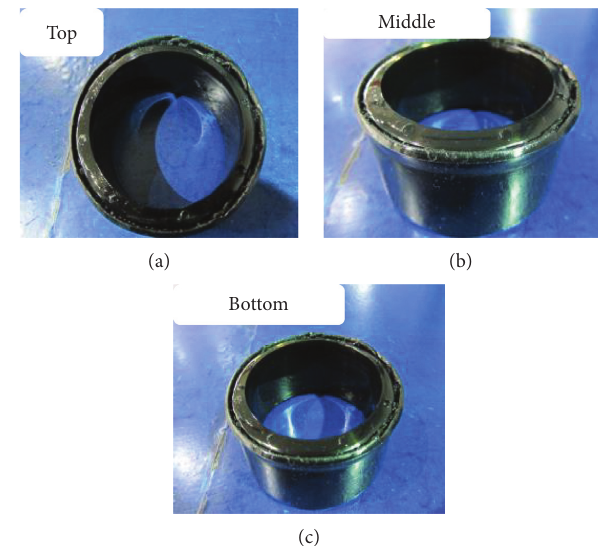
Figure 23: Deformation diagram of 2# rubber sleeve after